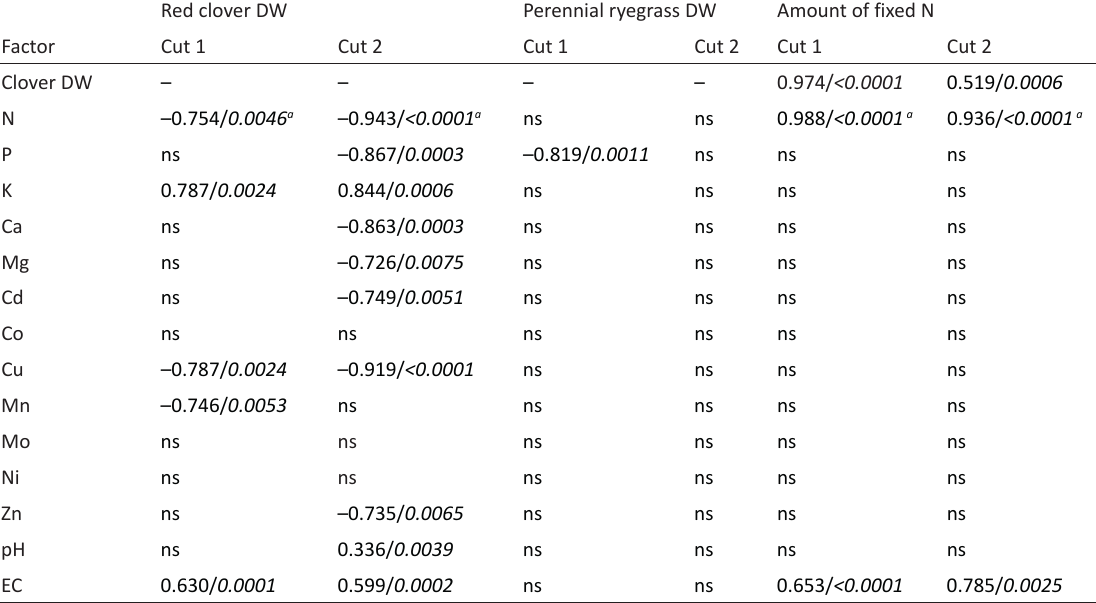
Table 5. Correlations between biomass dry weight (DW) and amounts of fixed N and soil pH, electrical conductivity (EC) and plant element concentrations at cut 1 and 2 for red clover and perennial ryegrass after controlling for family-wise error rate (Holm 1979), given as correlation coefficient/ p -value Red clover DW